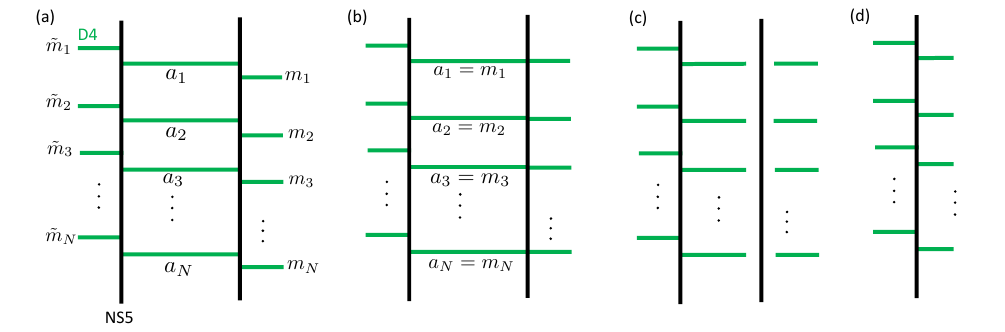
Figure 7 . Higgsing for the Hanany-Witten brane set up. By setting the Coulomb moduli param- eters to the masses of the fundamental multiplets, we can remove one of the